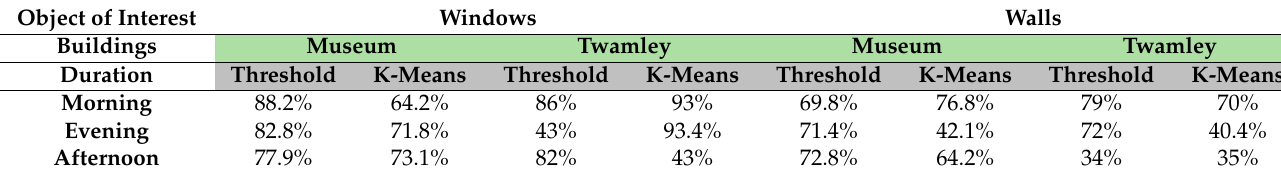
Table 7. Hotspot pixel overlapping (%) for windows and walls.